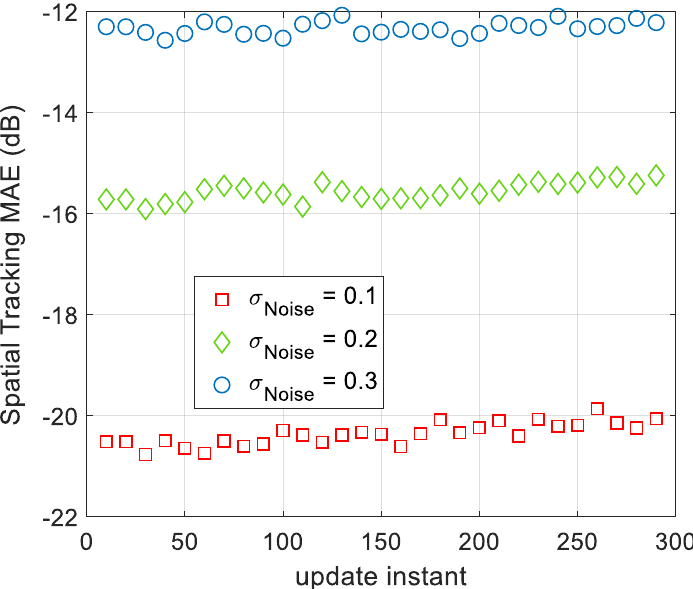
Figure 10. The spatial tracking MAE of AWSG at different observation noise’s strength. As the standard deviation of the observation noise increases, the modeling performance drops.